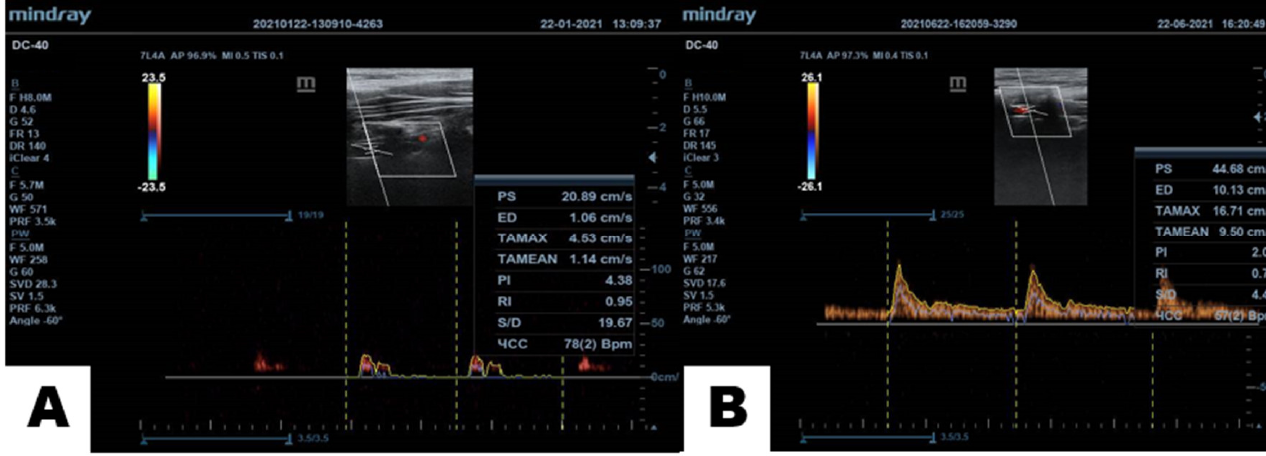
Figure 3. Restoration of V A of a 75.6 y/o patient. ( A )—V A measurements before and ( B )—5 months after the treatment according to [24,25]. The 10 fold increment of diastolic V A (ED) and nine fold increment of TAMEAN confirm the opening of the access to rhomboid fossa.